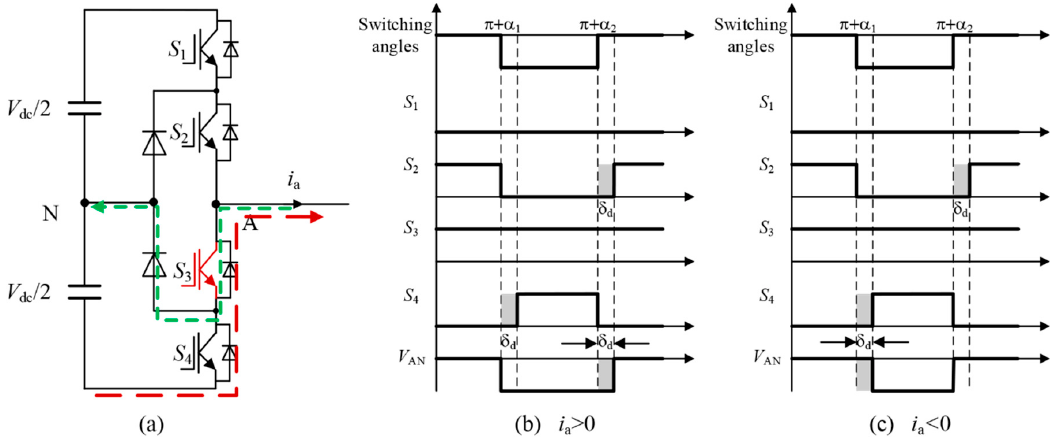
Figure 6. Current path ( a ), and output voltage during dead time, when i a > 0 ( b ), and i a < 0 ( c ), in the negative half cycle of the modulation voltage.